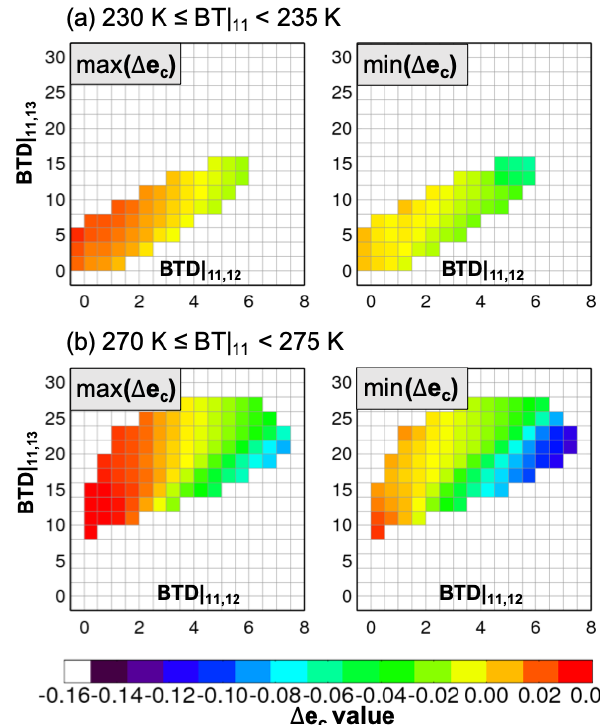
Figure 5. Look-up tables for min–max( (cid:49)e c ) (left and right pan- els in colors) by BTD | 11 , 12 ( x axis) and BTD | 11 , 13 ( y axis) for (a) 230K ≤ BT | 11 < 235K and (b) 270K ≤ BT | 11 < 275K. Identi- cal data as in Fig. 4 are used to generate these look-up tables, except that cloud emissivity differences between 11 and 12µm come from MODIS C6 (referring to Tables 1 and 2).